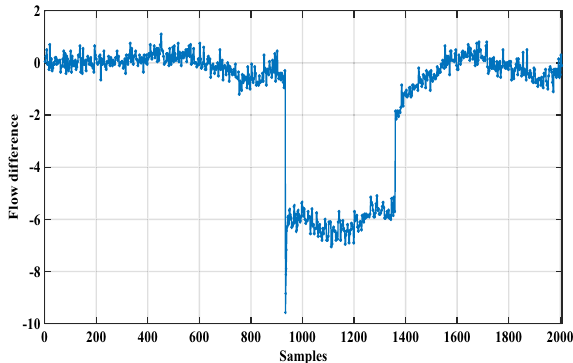
Figure 11. The flow difference of the oil pipeline.